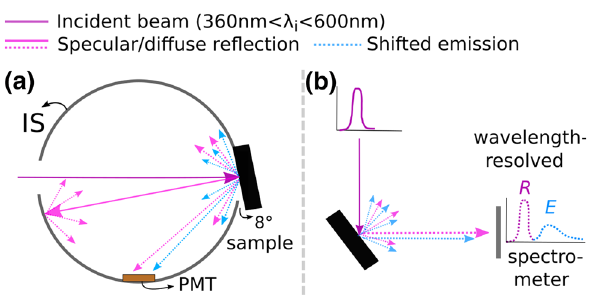
Fig. 4 a In the integrated measurement, the light enters the IS and reaches the sample, which is at an angle of 8 ◦ . Most of the diffuse and specular reflection of the sample are integrated by the IS before detection by a Hamamatsu R955 photomultiplier (PMT) [36]. b In the wavelength-resolvedmeasurement,thespectraofthereflected/scattered light (R) and shifted emission (E) are measured by a calibrated spec- trometer. In both setups, the sample holder backing the sample was not reflective